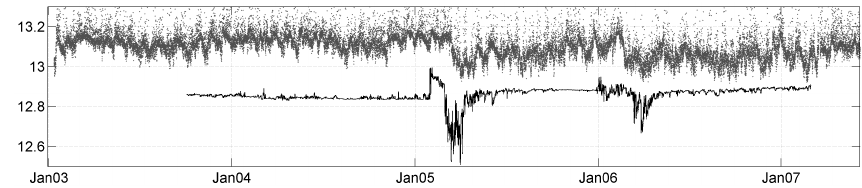
Fig. 15. Comparisons between θ time series at Camarinal Sill, Gibraltar (in grey), and on the Catalan slope (in black).